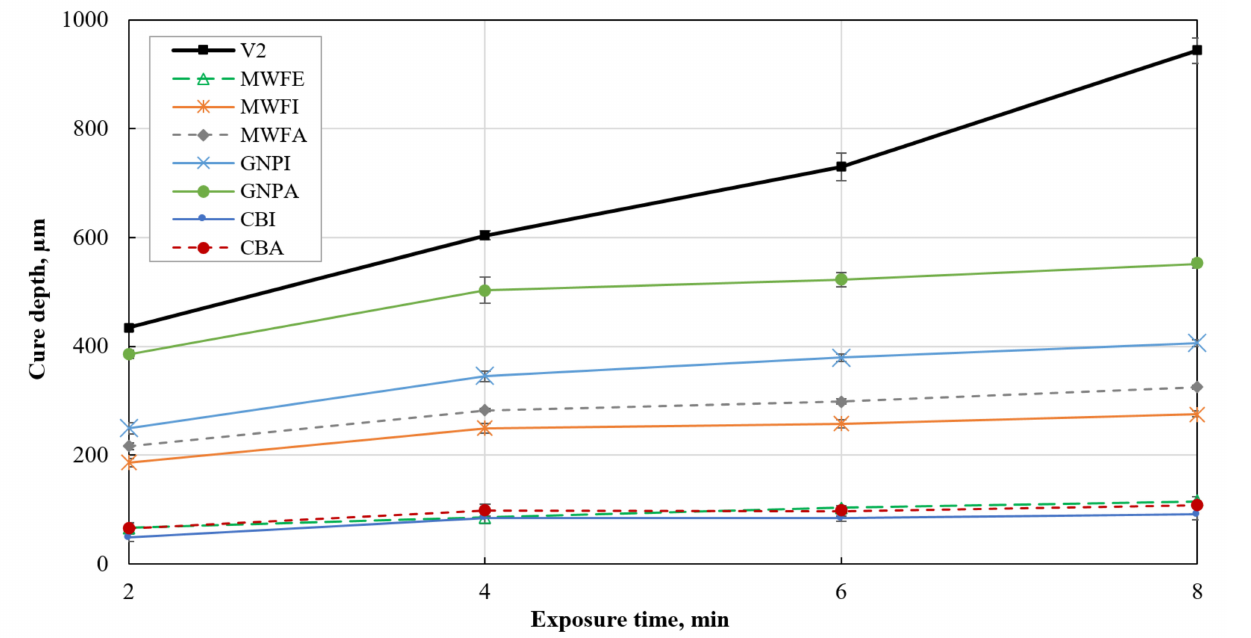
Figure 9. Cure depth of the suspensions at different exposure